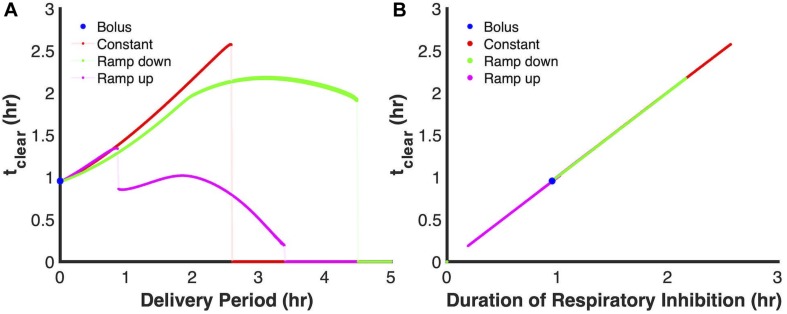
Duration of respiratory inhibition is a strong predictor of tclear. (A) Model predictions using the ensemble of parameter sets (ER < 10, 28 sets in total) for tclear as a function of delivery period when a 24 μmol PAPA NONOate payload is delivered. Solid lines represent the predicted relationship between tclear and delivery period (bolus- blue; constant-red; ramp down-green; ramp up-pink), while the lightly shaded lines represent discontinuities in the curves. (B) Plot of duration for respiratory inhibition vs. tclear. Duration of respiratory inhibition was defined as the length of time for which the percentage of NO bound cytochromes ≥ 99%.